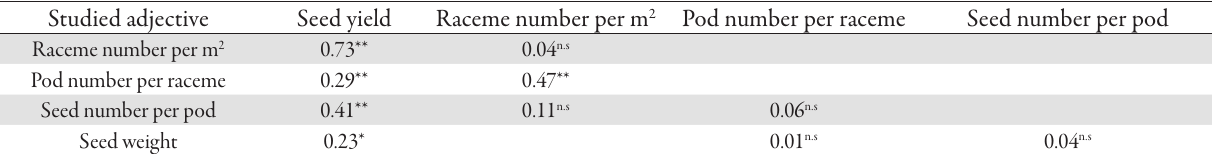
Tab. 5. Correlation coefficient between yield and Alfalfa seed yield components of ‘Mesasirsa’ figure Studied adjective